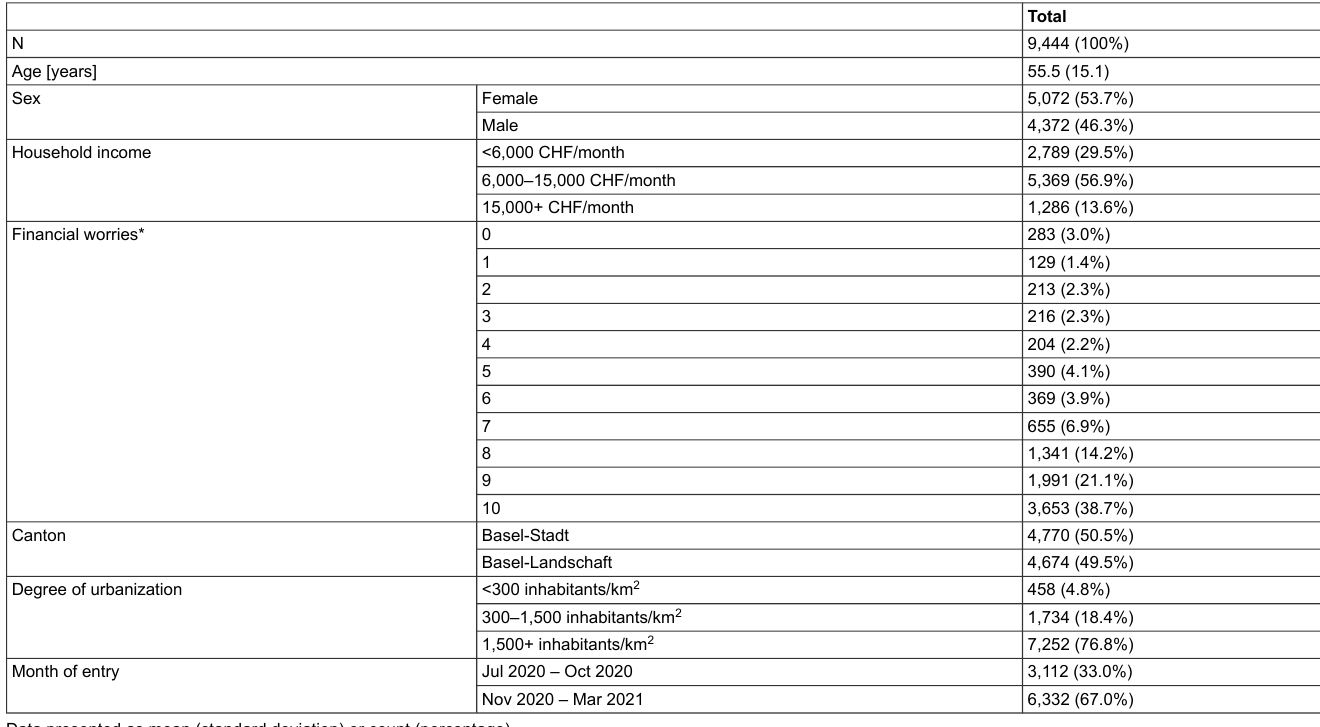
Table 1: Baseline characteristics of COVCO-Basel participants.